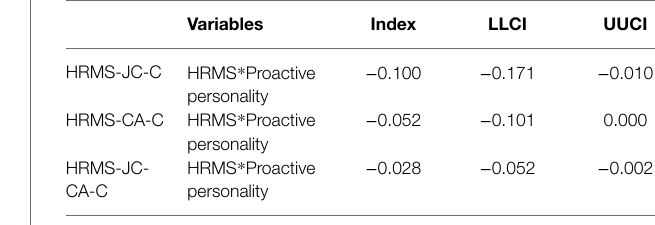
TABLE 8 | The moderating effect test.